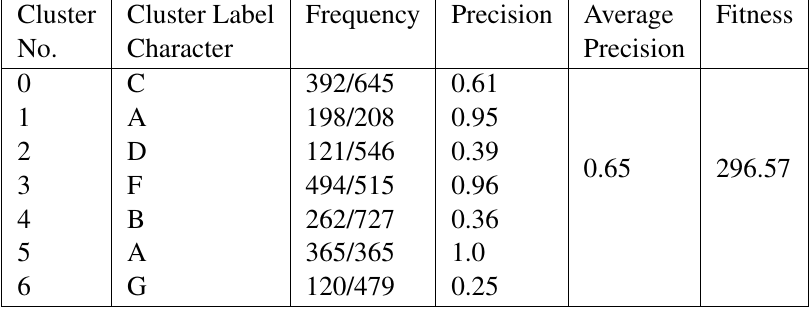
Table 6: Rough K-means algorithm clustering for characters from A to G. Cluster